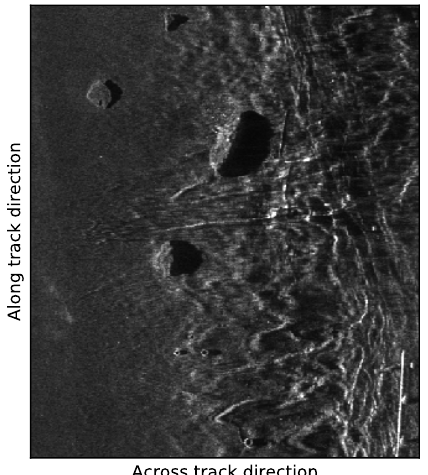
Figure 1. Example of a waterfall sidescan sonar image.